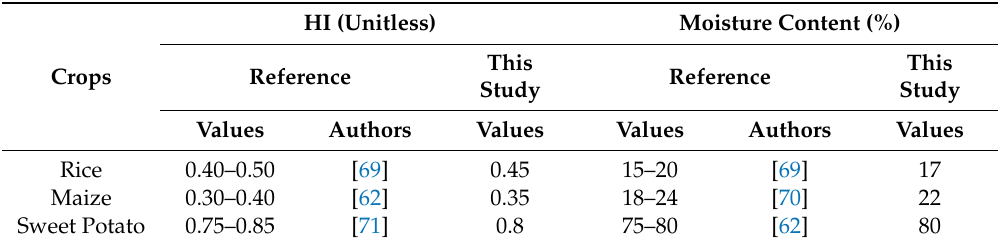
Table 2. Values of harvest index (HI) and moisture content for paddy rice, maize, and sweet potato used in this study. HI and moisture contents were chosen to reflect the common crop management practices across the Kou Valley irrigation scheme.